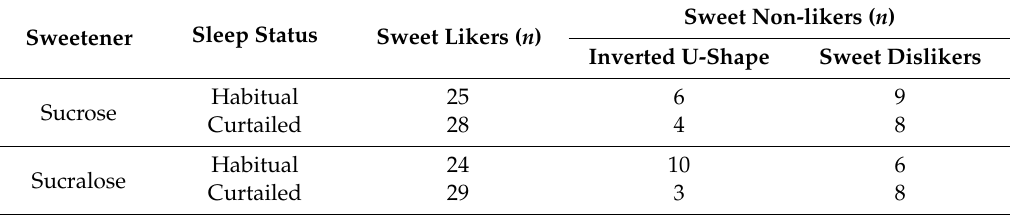
Table 4. Distribution of members between sweet liking phenotypes.